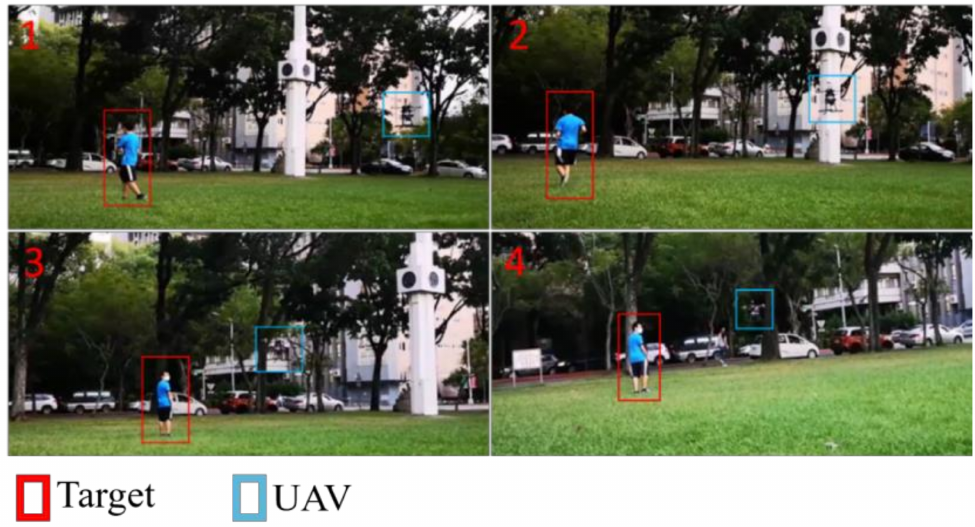
Figure 21. UAV tracking target test outdoors (The sequence of target movement and UAV tracking is shown in 1 – 4 ).